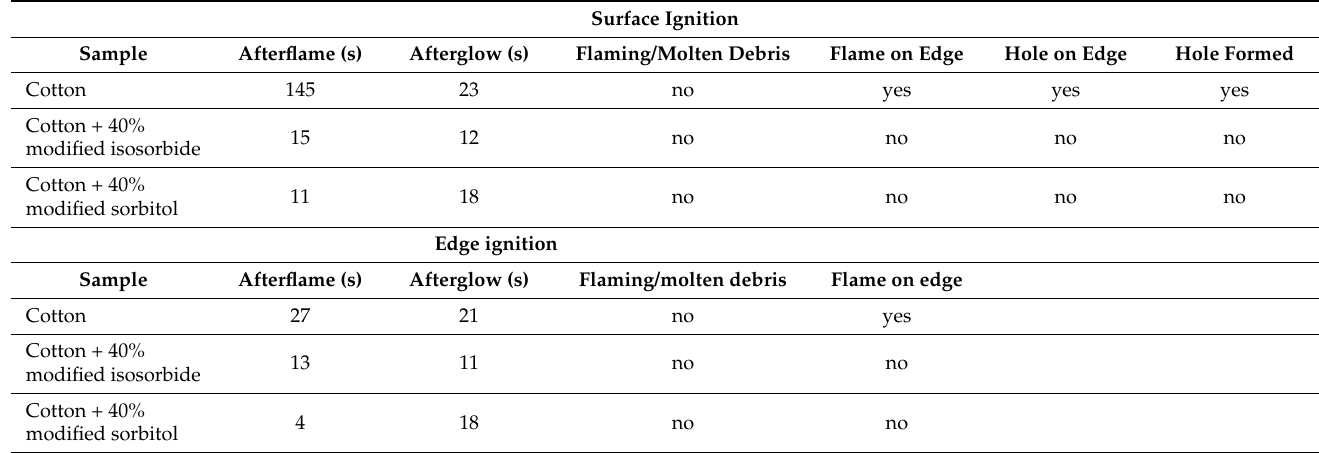
Table 2. Overview of ISO 15025 results after five washing cycles (40 ◦